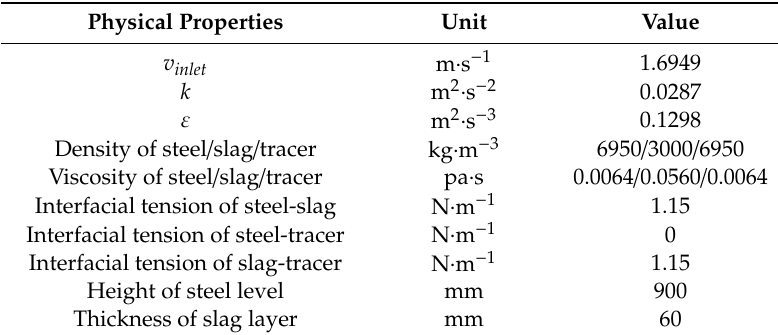
Table 1. Initial basic setting of the